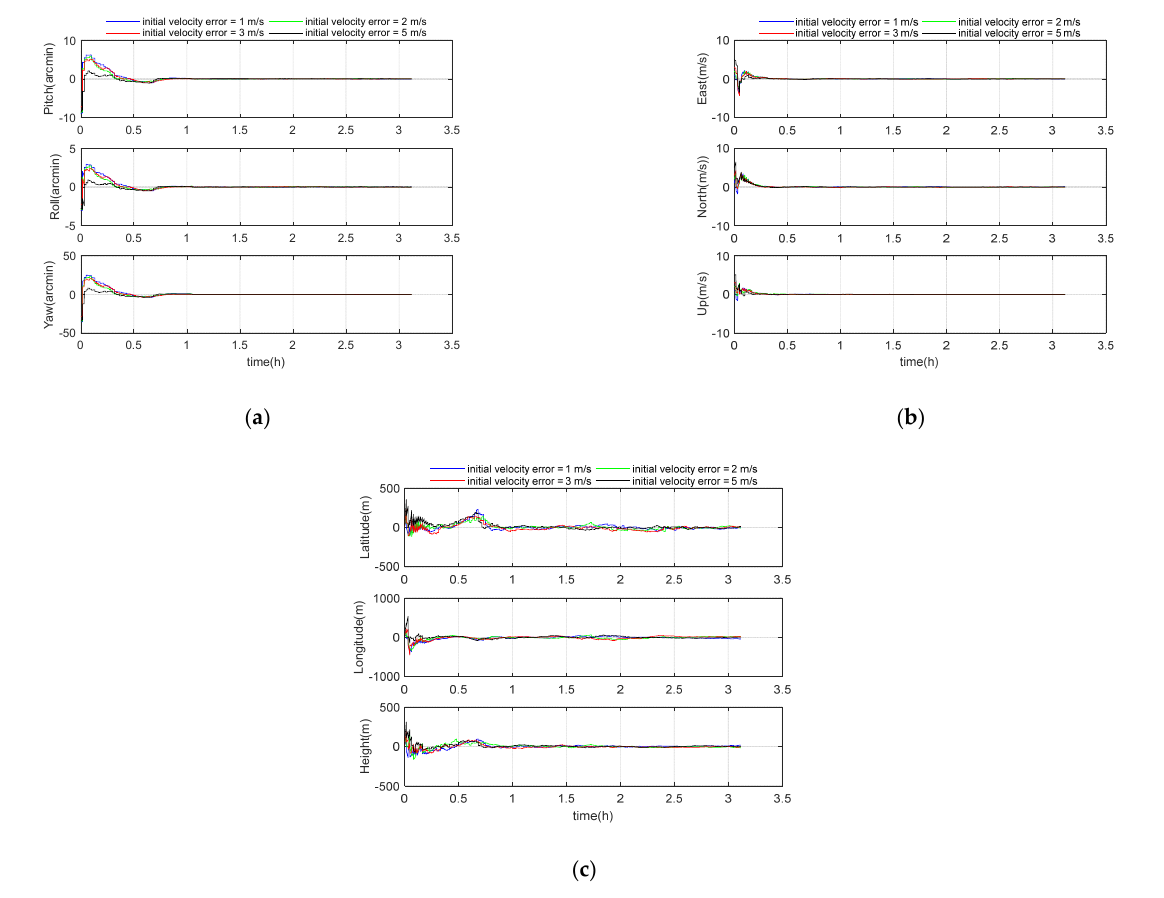
Figure 8. ( a ) Attitude error curve; ( b ) velocity error curve; ( c ) position error curve. Table 7. Simulation results under different initial velocity errors.